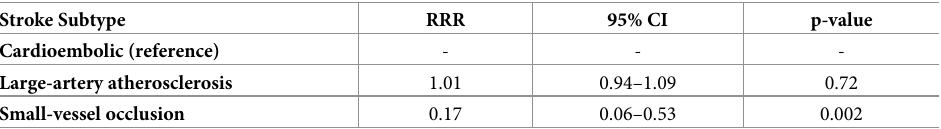
a Abbreviations: RRR = relative risk ratio, CI = confidence interval.